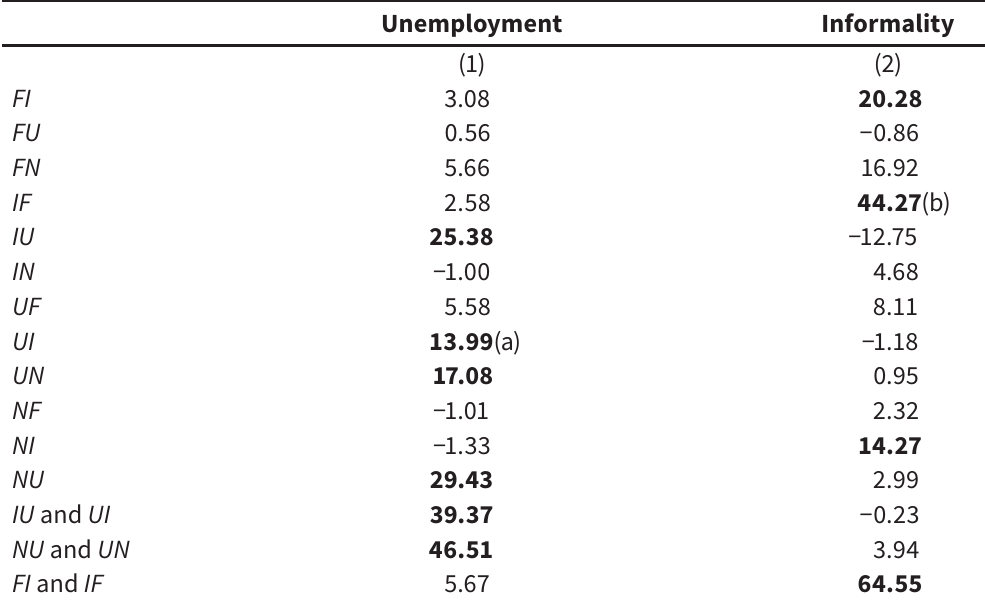
Variance Decomposition based on b in%. 2003Q3-2020Q1 Unemployment